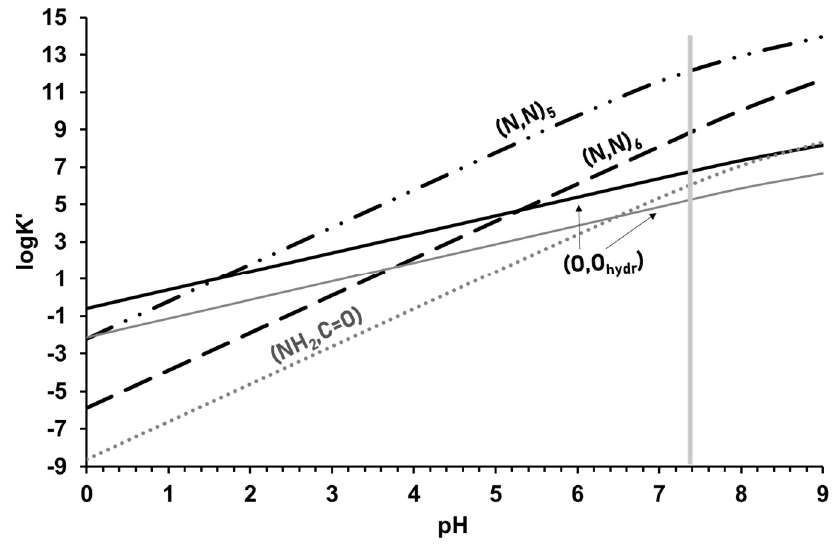
Figure 4. pH-dependence of the logK’ conditional stability constants at 0.20 M KNO 3 for a model 5-membered and 6-membered (N,N) chelate (formed with en and pn, respectively), as well as for a 5-membered (O,O) (formed with aha − at 0.20 M KNO 3 or at 0.20 M KCl) and for a 5-membered (N amino ,O carb ) chelate (formed with GlyGlyAla − at 0.20 M KCl) in their interaction with [(η 5 -Cp*)Rh] 2+ . Black lines indicate logK’ values determined in KNO 3 , while grey lines, values obtained in KCl medium. Vertical line indicates pH = 7.4.